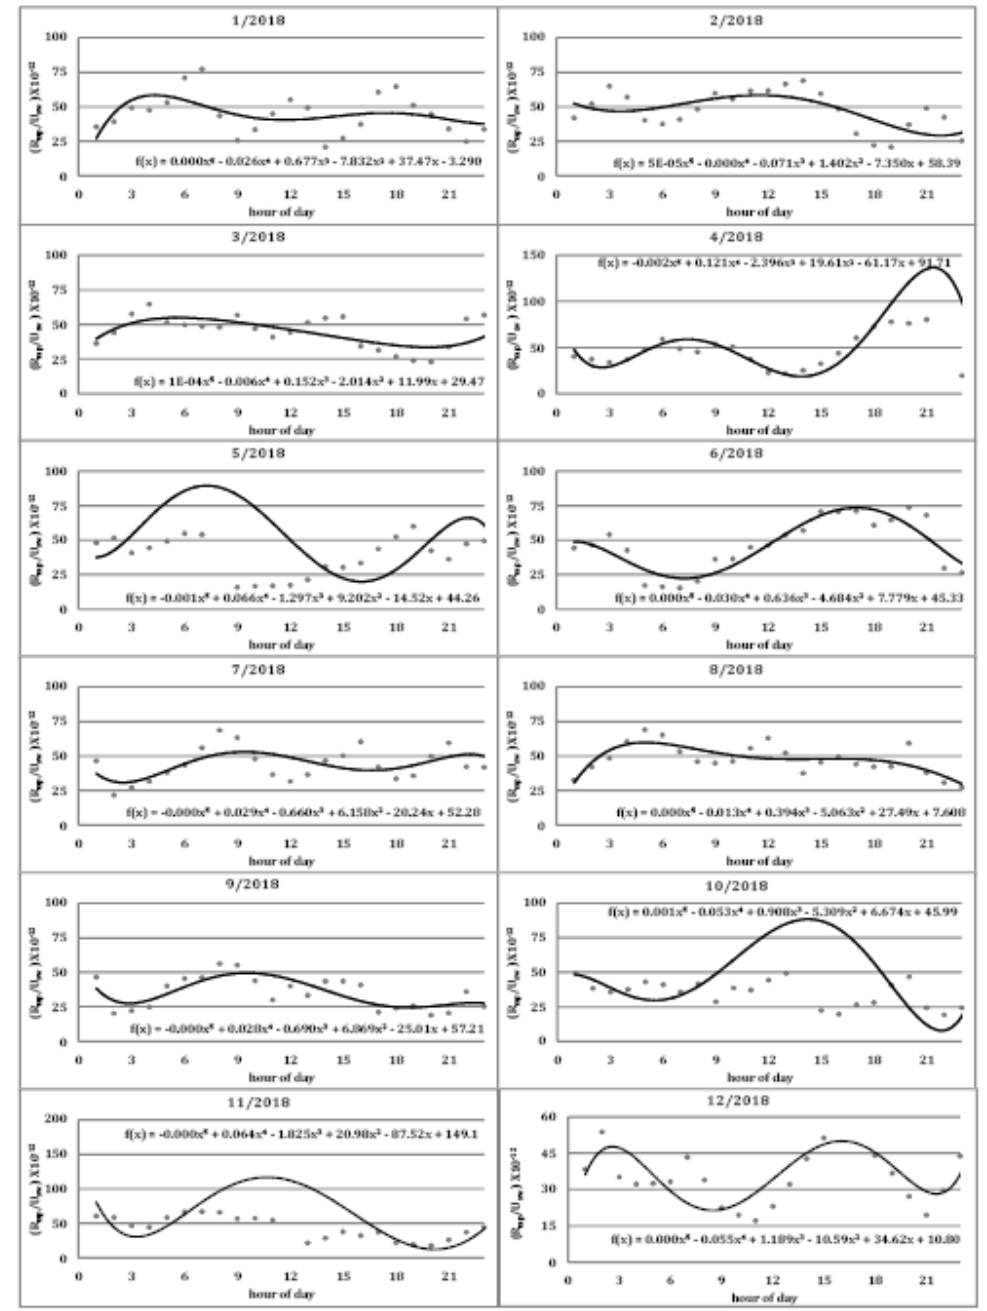
Fig. 8: Monthly median of (R